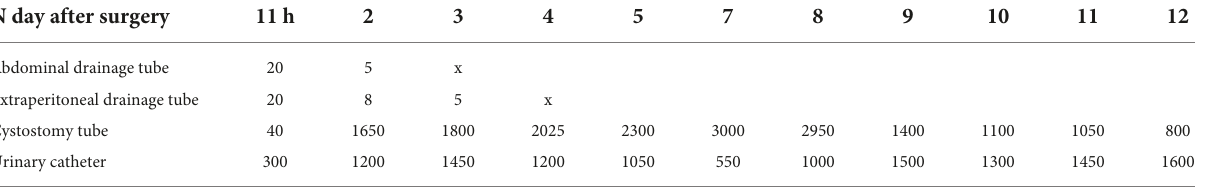
TABLE 2 Post-operative abdominal drainage tube drainage statistics (ml). N day after